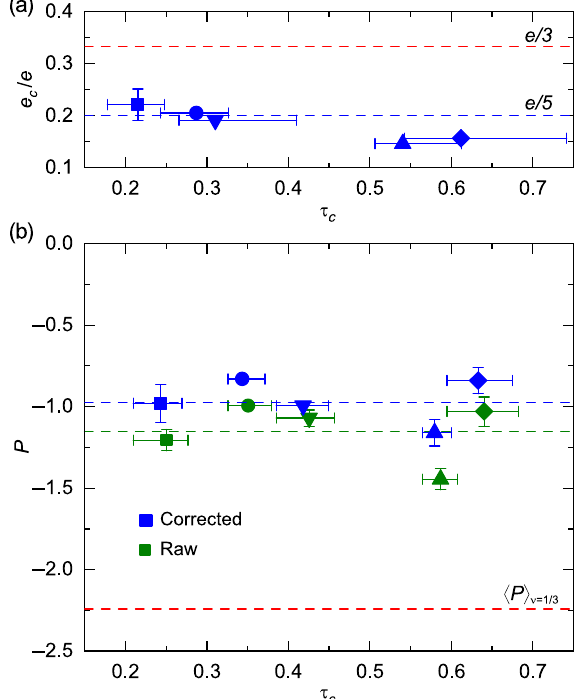
FIG. 8. Effective Fano factor for e= 5 quasiparticles at ν ¼ 2 = 5 . (a) Separately characterized analyzer tunneling charge e τ . (b) Experimental value of P with (blue symbols) and without c (green symbols) correcting for interchannel tunneling. The same symbol as in (a) represents an identical device tuning ( τ due to a different biasing). The horizontal dashed lines indicate the corresponding mean values h P i ≃ − 0 . 97 (blue) and h P i ≃ − 1 . 15 (green), together with the ν ¼ 1 = 3 observation h P i ≃ − 2 . 24 (red). Error bars are displayed in (a) and (b) when larger than the symbols. Horizontal error bars display the variation of τ during the measurement. Vertical error bars show the difference between values obtained separately for negative and positive applied